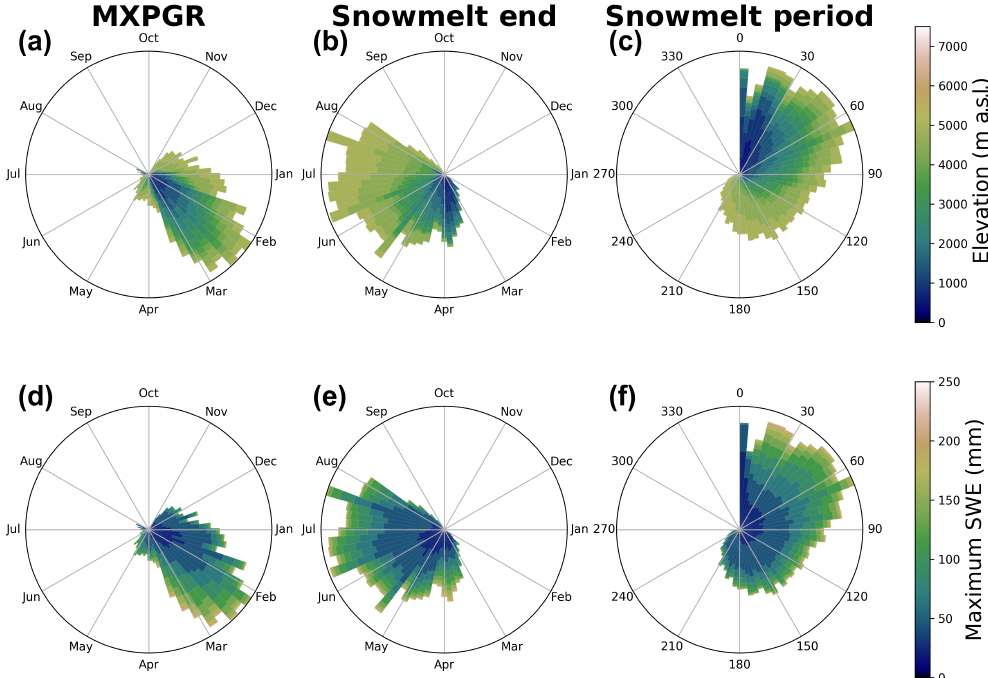
Figure 7. MXPGR (a, d) , snowmelt end (b, e) , and snowmelt period (c, f) for the entire study area, colored by elevation (a–c) and snow depth (d–f) bins. Radial bin heights (radial distance from the center) indicate relative number of pixels at each day of year (i.e., area). While very short snowmelt periods show a distinct low-elevation, low-SWE bias, in general melt onset and end dates are well distributed throughout elevation zones and SWE